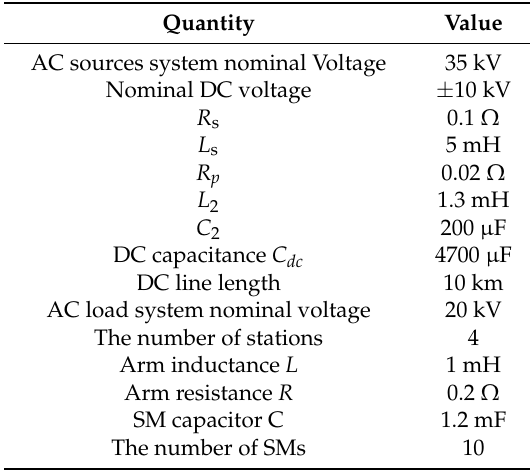
Table 1. Parameters for the Study System of Figure 1 (Sub-Module